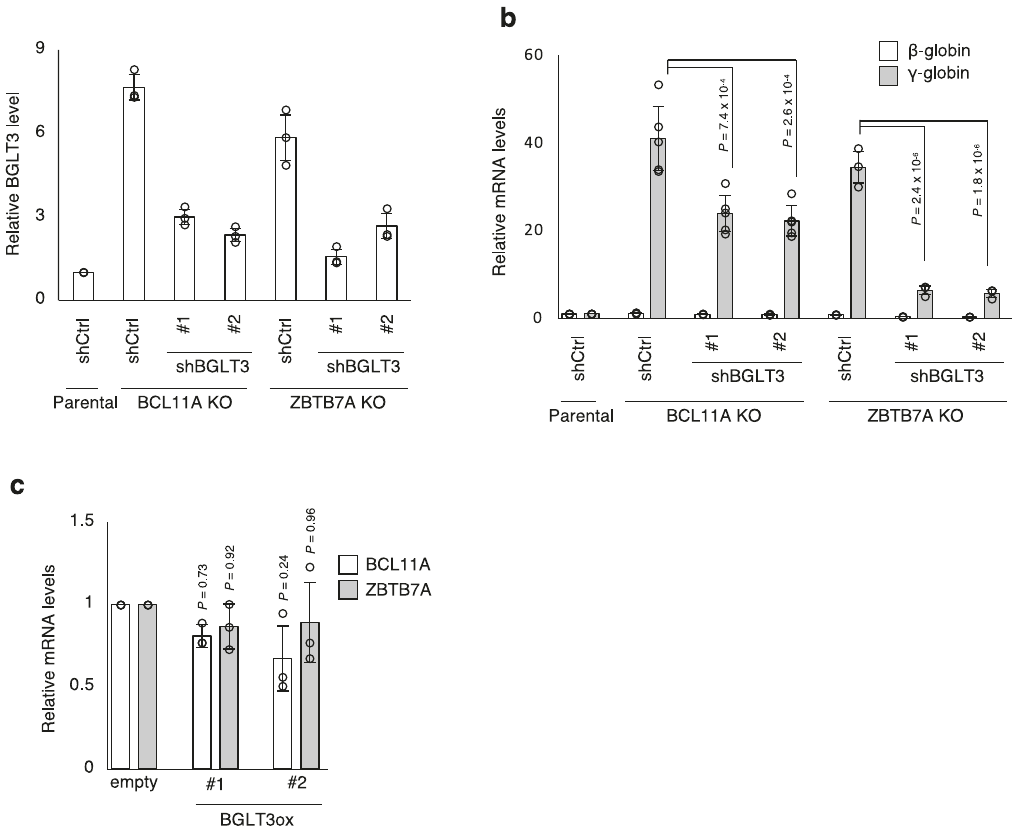
Fig. 6 | The role of BGLT3 in γ -globin induction by BCL11A and ZBTB7A. a Validation of shRNA-mediated knockdown ef fi ciency of BGLT3 in BCL11A- or ZBTB7A-knockout HUDEP-2 cells. Data are mean±SD from three independent experiments. b Relative expression of γ -globin in BCL11A- or ZBTB7A-knockout HUDEP-2 cells with or without BGLT3 knockdown. Data are mean±SD from three